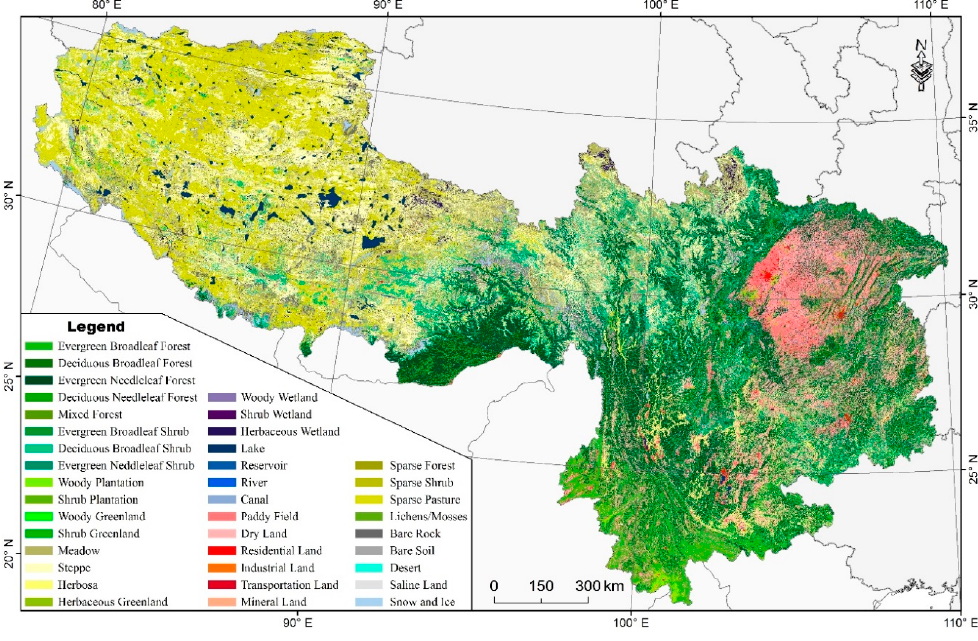
Figure 11. The CLC-SW2010 product. Table 4. The confusion matrix of primary categories in the CLC-SW2010 product. The codes of each primary category are the same as the ones listed in Table 1.